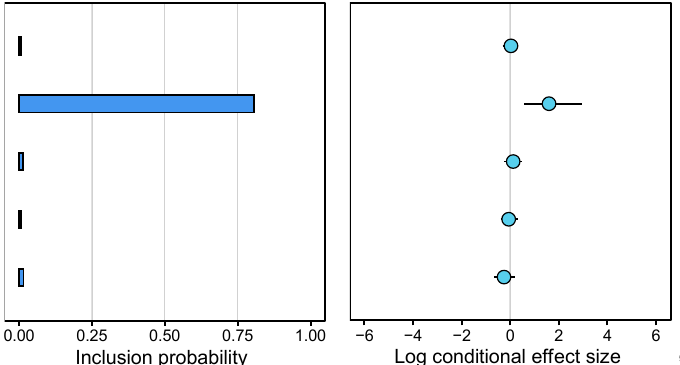
Figure 3. Support and contribution of potential predictors in the phylogenetic Generalized Linear Model (GLM) of rabies CST events within the Myotis genus only. For each potential predictor, support is represented by an inclusion probability and a relative contribution indicated for log scale GLM coefficients conditional on the predictor being included in the model (posterior mean and 95% Bayesian confidence interval). Range overlap was the only supported predictor (BF = 27.9).